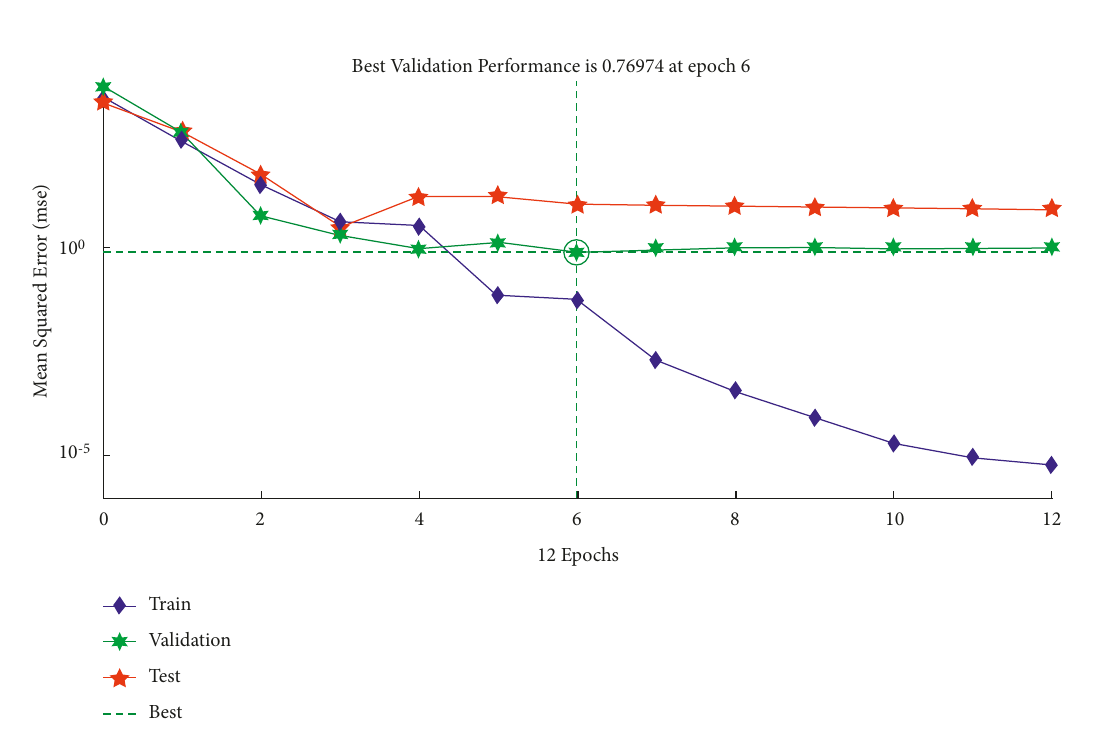
Figure 2: Performance verification using